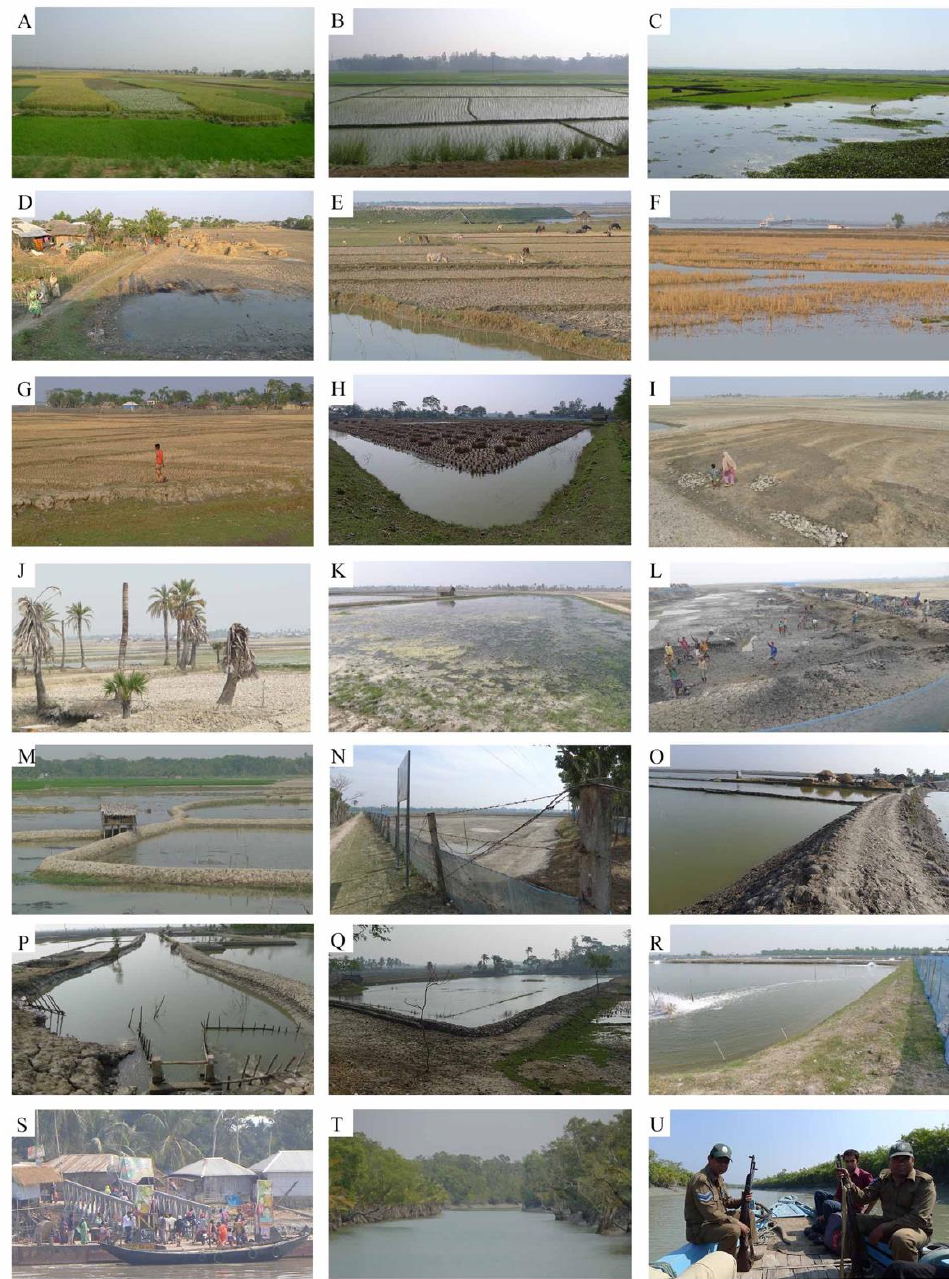
Figure 2. Field photos of land cover in the dry season (Jan – Mar) collected by the authors on 5 campaigns over the years 2012 – 2017. Double cropped agriculture ( A – C ) is present, as well as dry and inundated rice stubble ( D – H ). Soil salinization and attempts to reconvert back to agriculture from aquaculture ( I – K ), as well as various aquaculture methods ( L – R ) are clearly evident. Substantial economic activity occurs on the waterways surrounding the polders ( S ). The biodiversity hotspot of the Sundarbans mangrove forest ( T , U ) directly abuts the polders.